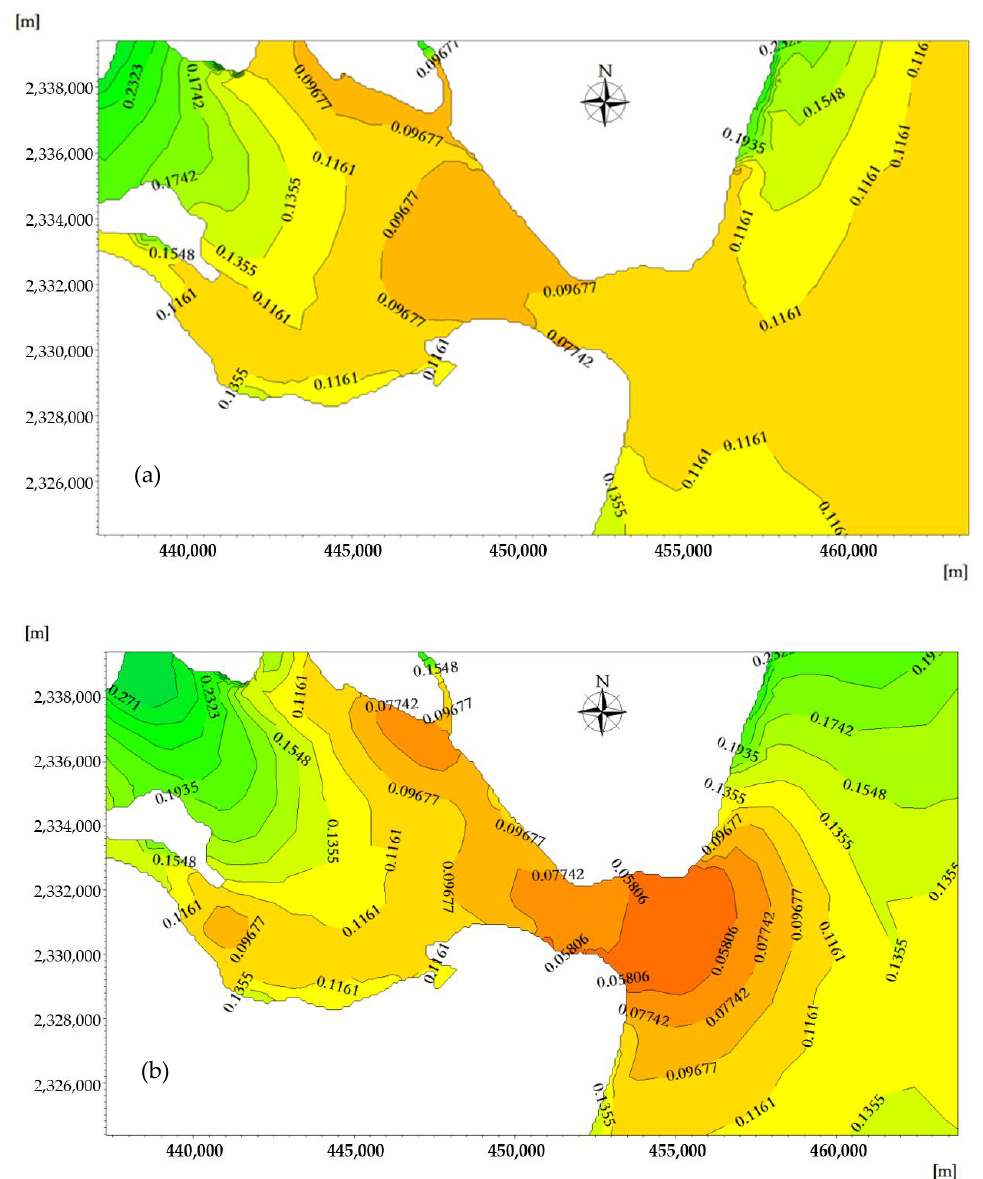
Figure 16. The spatiotemporal distribution of the nitrate concentration near the tidal inlet at the moment when the velocity of the flood tide ( a ) and ebb tide ( b ) reaches its maximum (mg/L).